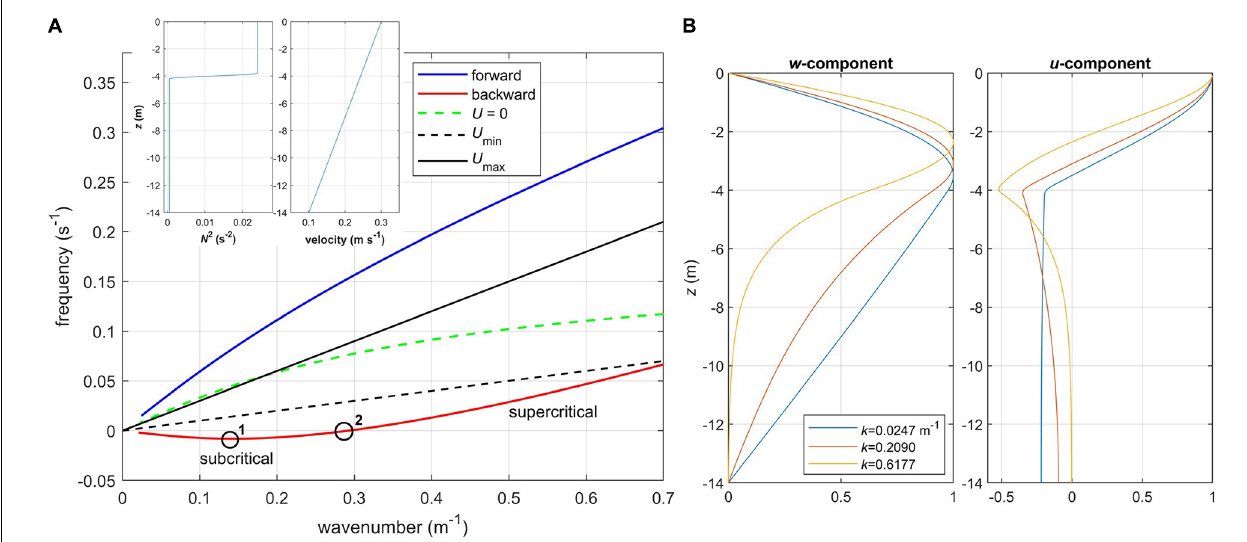
FIGURE 11 | Internal wave properties, case 1: (A) dispersion diagram for the first mode. Points 1 and 2 on the dispersion curve for backward propagating mode are C g = 0 and C = 0, respectively. Inset shows profiles of buoyancy frequency squared (left) and mean velocity (right) specified in the wave Equation A7; (B) vertical profiles of vertical and horizontal velocity components normalized by their maximum values for various wavenumbers k , forward propagating mode.